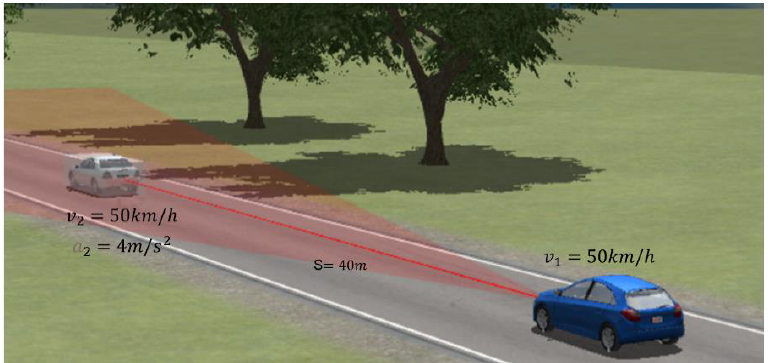
Figure 8. AEBS test scenario in Carsim.